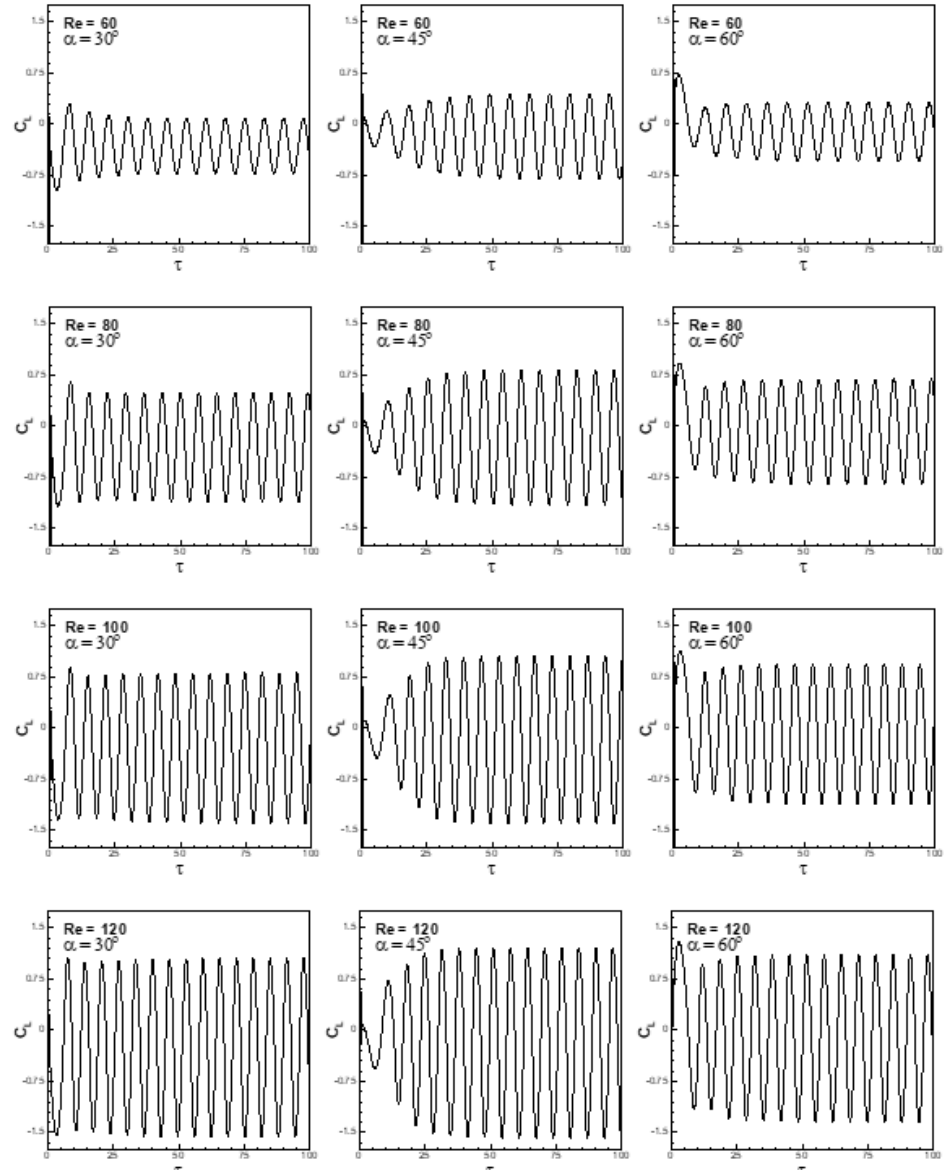
Figure 16. Temporal variation of lift coefficient for the conditions (Ri = 0.2, 60 ≤ Re ≤ 120 and 30° ≤ α ≤ 60°).